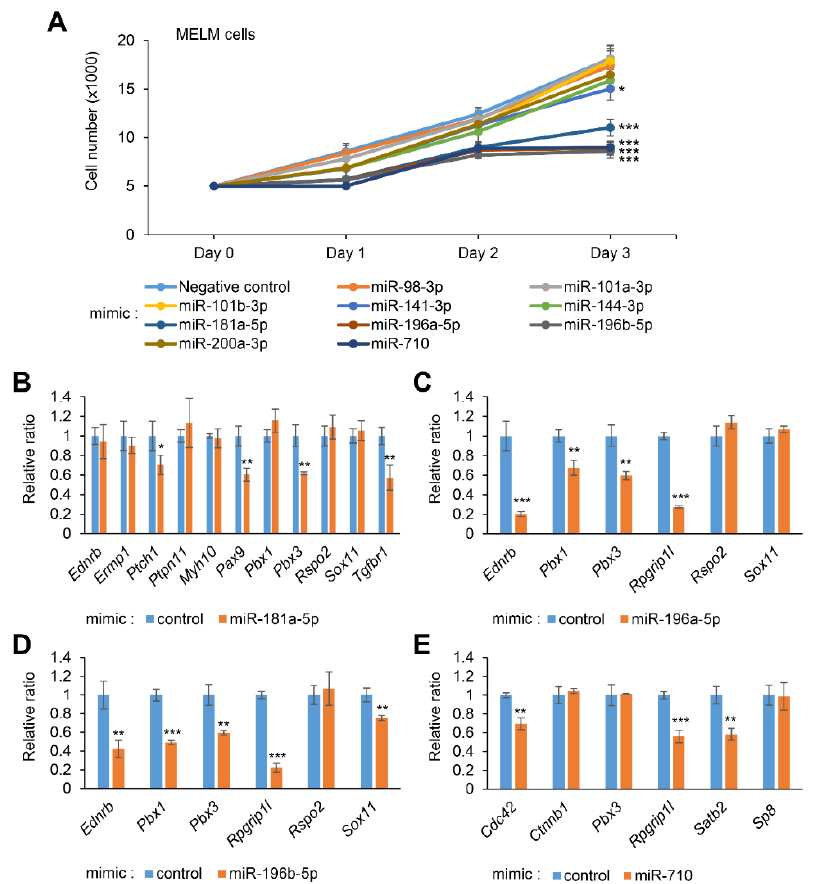
Figure 1. Effect of overexpression of the predicted microRNAs (miRNAs) on proliferation of mouse embryonic lip mesenchymal (MELM) cells. ( A ) Cell proliferation assays with primary MELM cells treated with the indicated miRNA mimic for control, miR-98-3p, miR-101a-3p, miR-101b-3p, miR-141-3p, miR-144-3p, miR-181a-5p, miR-196a-5p, miR-196b-5p, miR-200a-3p, and miR-710. * p < 0.05, *** p < 0.001. Each treatment group was compared to the control. ( B – E ) Quantitative RT-PCR for the indicated genes after treatment of primary MELM cells with control or miR-181a-5p mimic ( B ), miR-196a-5p mimic ( C ), miR-196b-5p mimic ( D ), and miR-710 mimic ( E ). * p < 0.05, ** p < 0.01, *** p < 0.001 versus control ( n = 6).